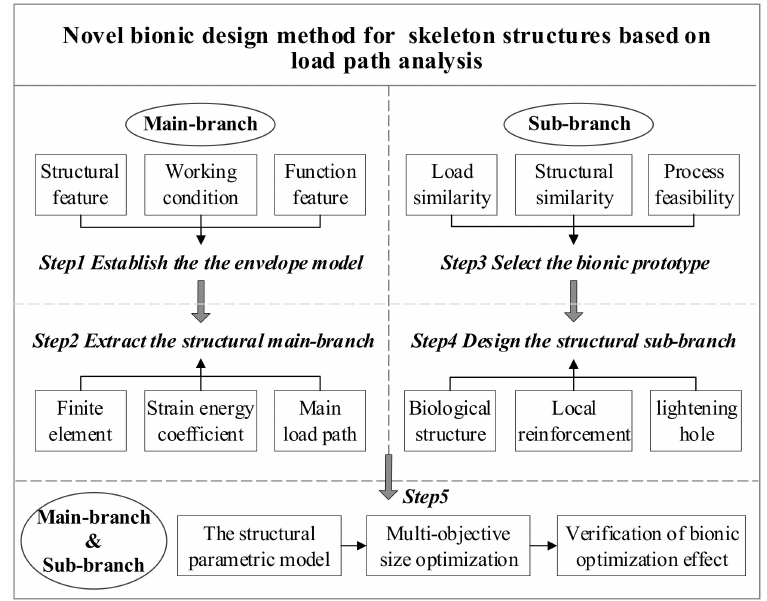
Figure 1. Bionic design method based on the idea of main-branch and